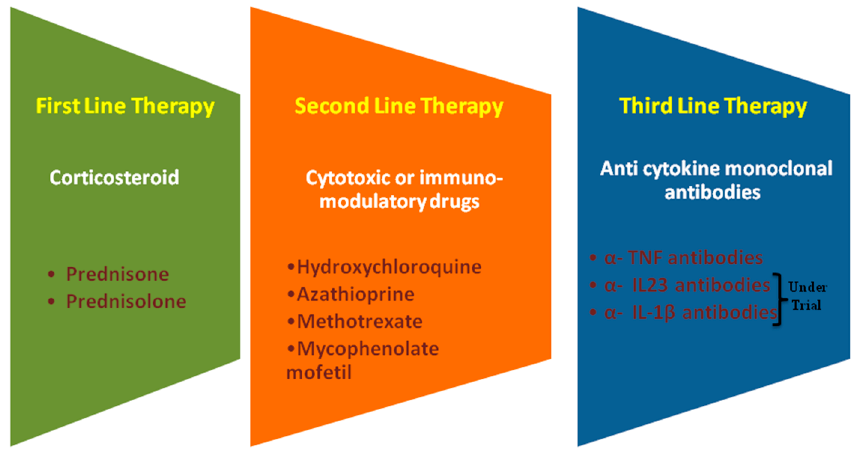
Figure 2. Therapeutic options for first, second, and third-line treatment of